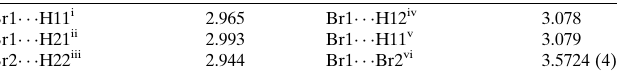
Selected contacts (A˚